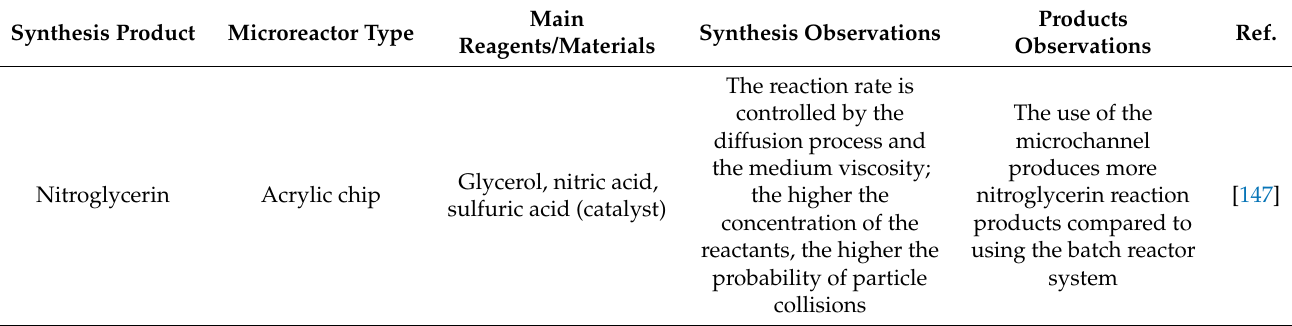
Table 5. Summary of active pharmaceutical ingredients synthesized via microfluidic